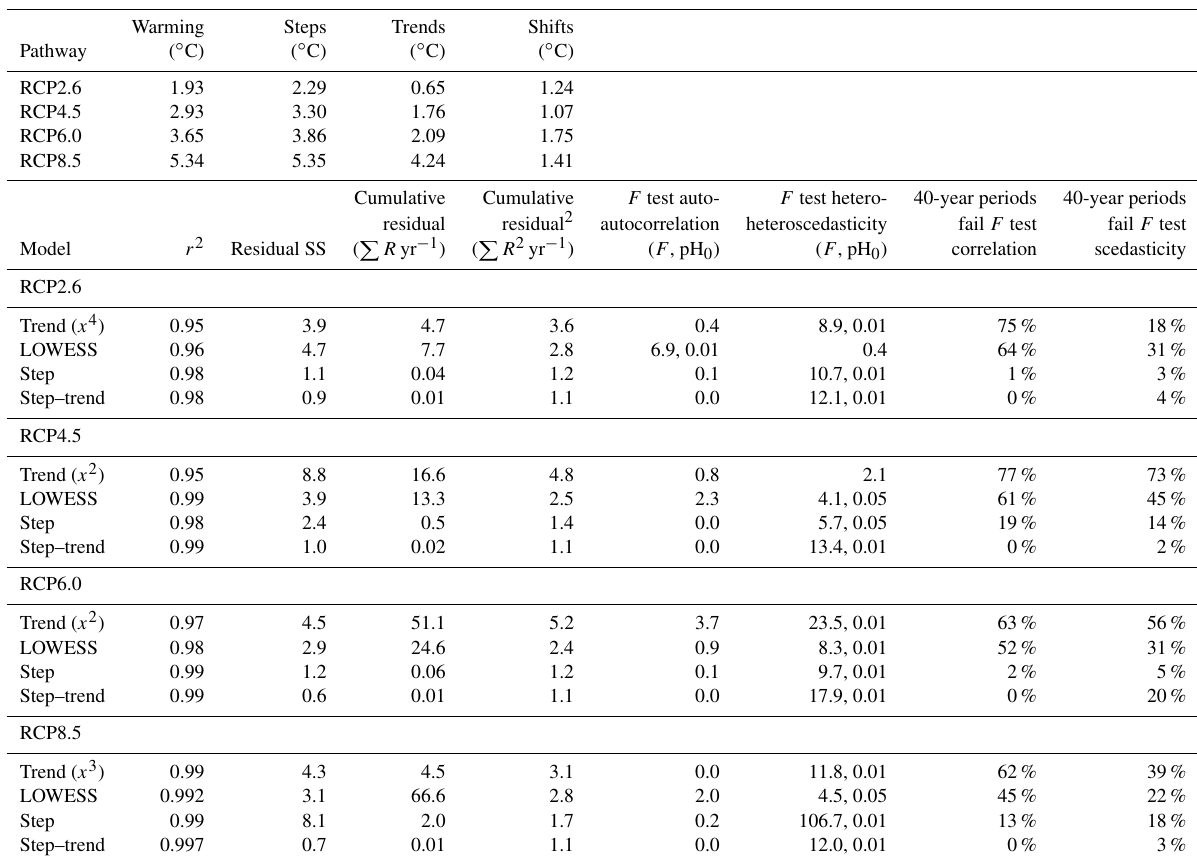
Table 5. Results of eight tests on four statistical models for representing global mean warming from HadGEM-ES climate model run 3 RCP2.6, 4.5, 6.0 and 8.5, showing the amount of warming for different measures. The statistical models tested are trends (power shown), LOWESS (0.5 total series smoothing), steps, and steps and trends. Results include the adjusted r 2 value, the residual sum of squares (SS), cumulative residuals and squared cumulative residuals. F tests for the whole series are shown, with p <0.05 and p <0.01 noted if registered, otherwise p >0.05. F test failure for 40-year period autocorrelation and heteroscedasticity is measured at p